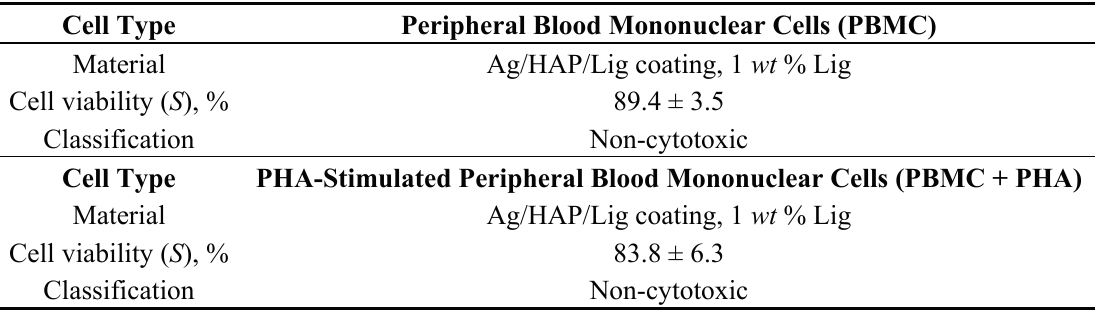
Table 4. Cell survival of PBMC and PBMC PHA-stimulated in the presence of sintered Ag/HAP/Lig